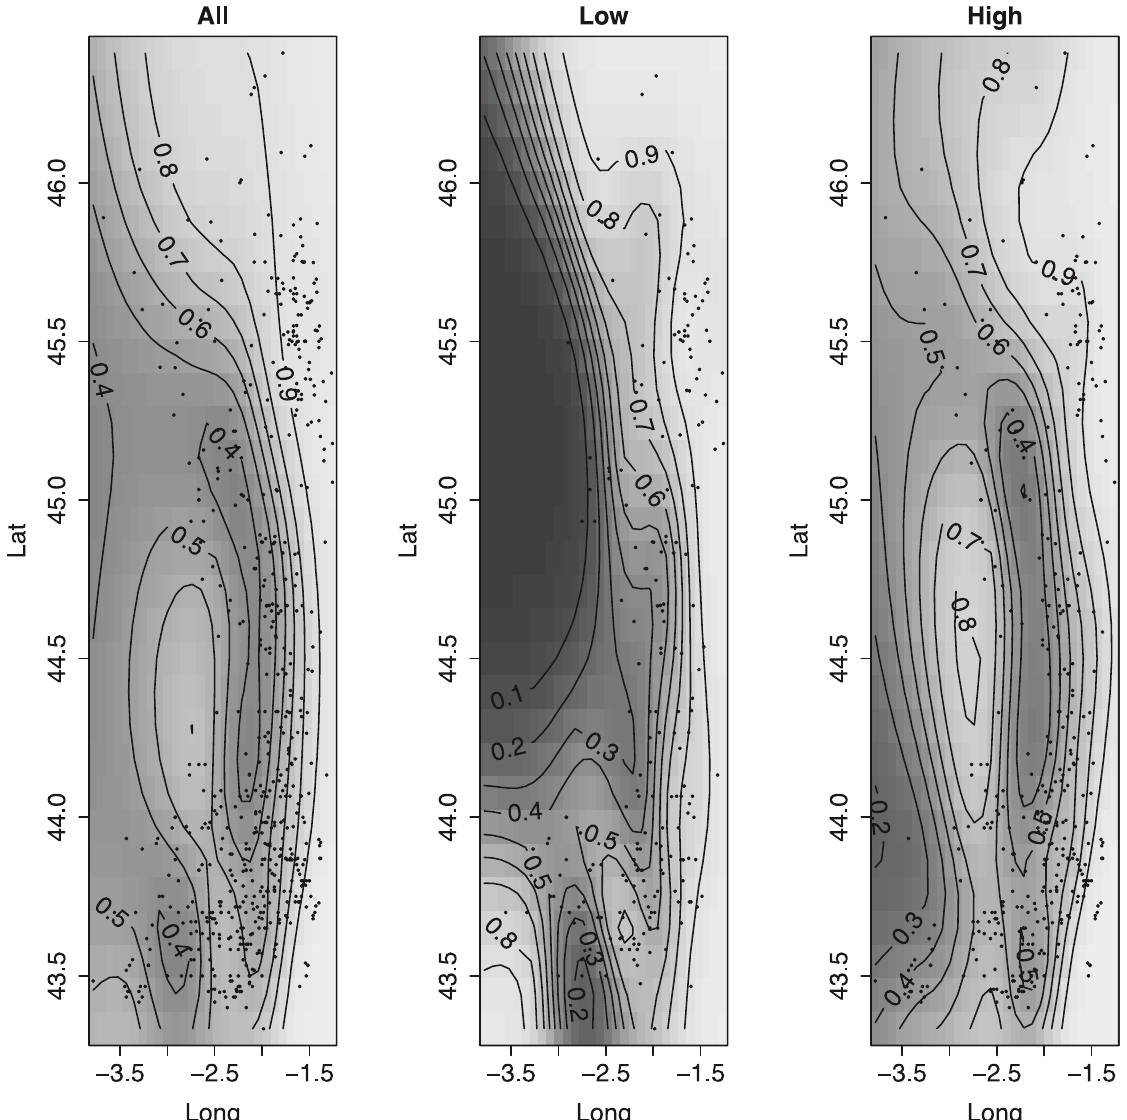
Fig . 5. – Bivariate geographical smooth function depending on longitude and latitude when the bivariate geographical smooth function of longitude and latitude is independent (left panel) and dependent (mid and right panels) on P . The mid- and right panels correspond to the low-high low and high age-1 proportion levels,